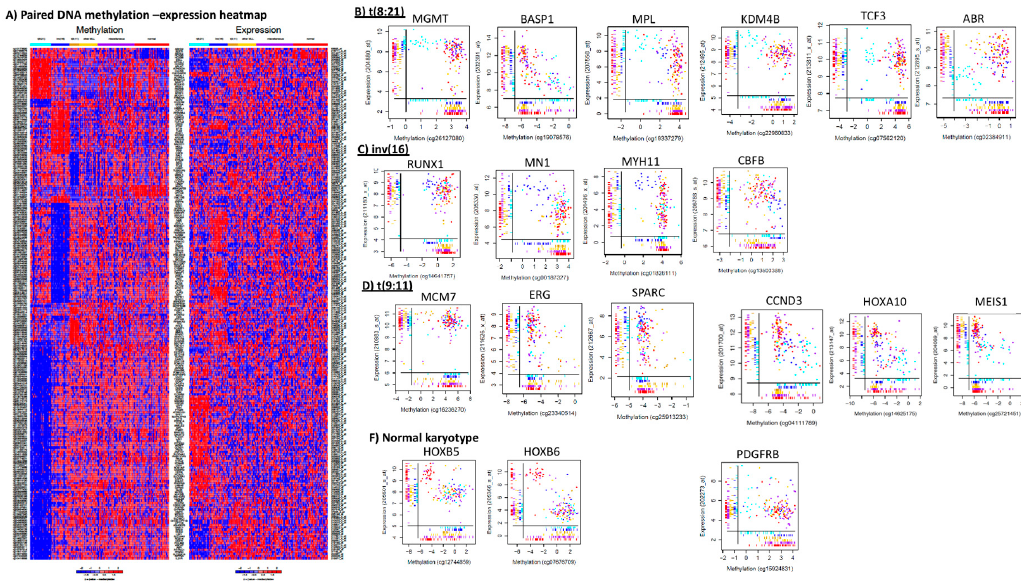
Figure 3. ( A ) Paired methylation and expression heatmap showing most significant features within each of the cytogenetic groups. Selected genes unique to different cytogenetic subgroups are shown in panels on right: ( B ) Inv(16); ( C ) t(8:21); ( D ) t(9:11); ( E ) other 11q23 MLL rearrangements; ( F ) normal cytogenetics and ( G ) Miscellaneous karyotype. Color for each cytogenetic group corresponds to the bar on top of the heatmaps.